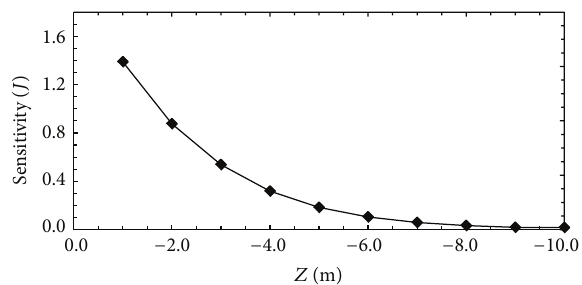
Figure 2: The original sensitivity changes as a function of 𝑍 at 𝑋 = 0 .